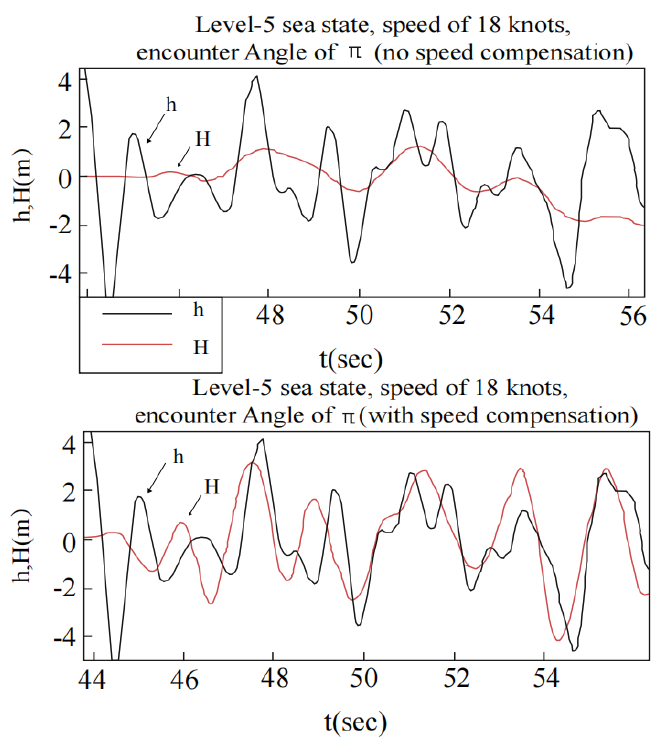
Figure 21. Response curves of aircraft tracking deck motion under level-5 sea state, speed V = 18 Kn and encounter angle β = π .